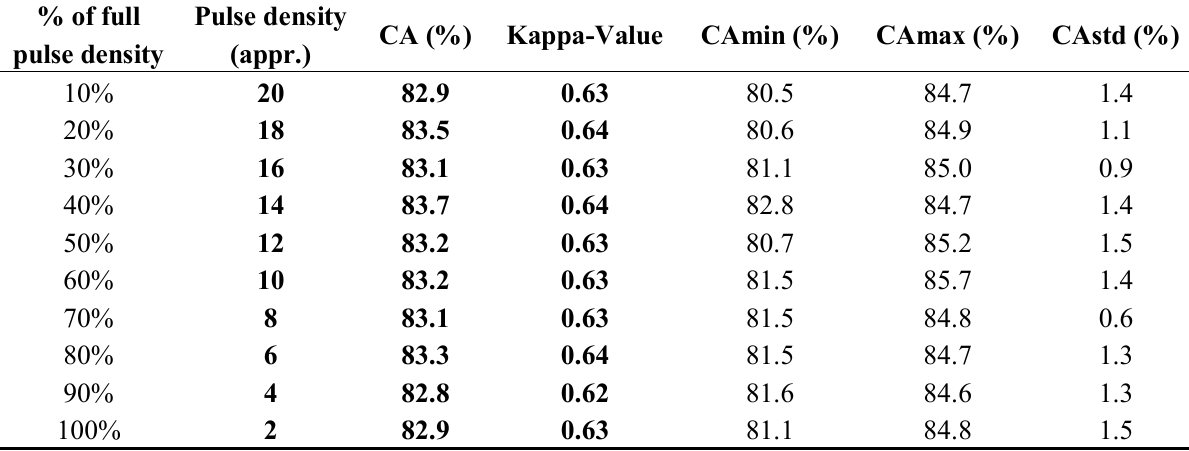
Table 6. The overall classification accuracies (CA), minimum and maximum accuracies, standard deviation, and kappa-values for different pulse